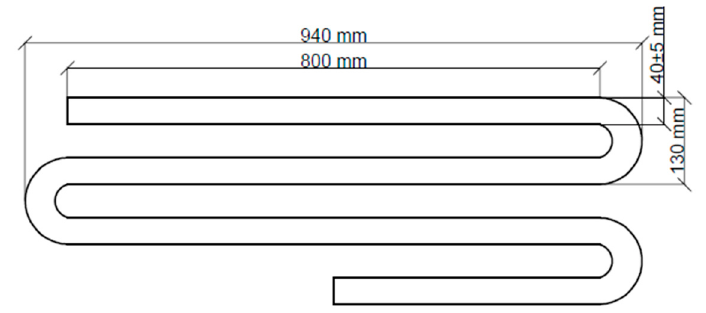
Figure 5. Design of the print path.